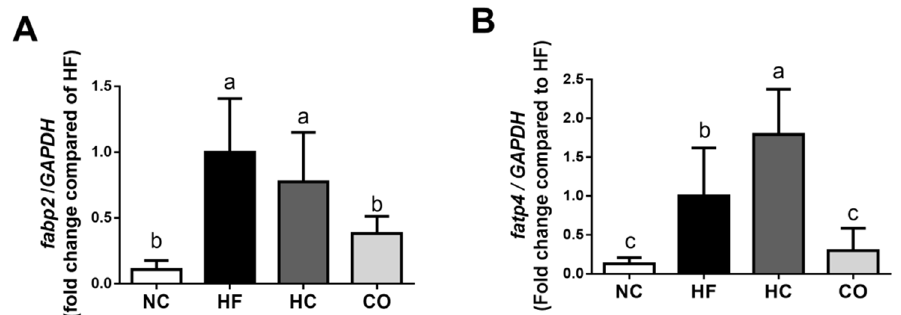
Figure 7. The changes in intestinal fabp2 ( A ) and fatp4 ( B ) mRNA expression in rats fed with different experimental diets for 12 weeks. Data are expressed as the mean ± S.D. for each group ( n = 6). Values with different superscript letters (a, b, c) are significantly different from each other ( p < 0.05). NC: Normal control diet (chow diet). HF: High-fat diet (chow diet + 10% lard). HC: HF diet + 5%